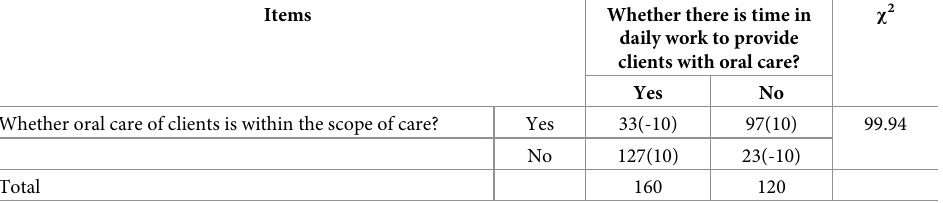
Table 3. The cross-analysis between “whether the oral care of clients is within the scope of care” and “whether time exists in daily work to provide clients with oral care.” Items Whether there is time in